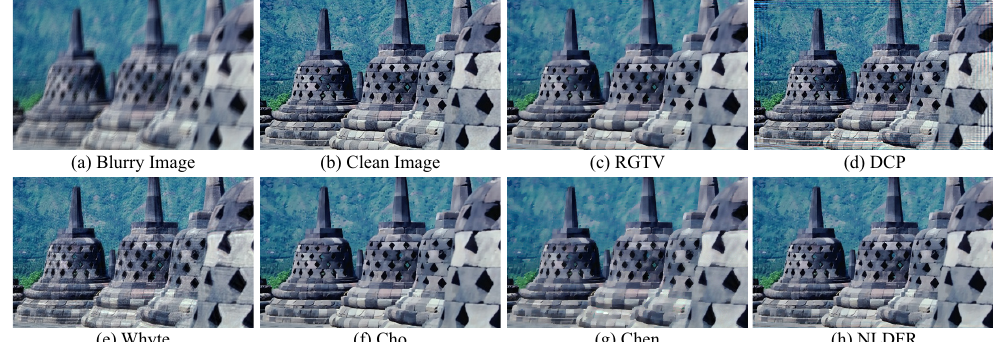
Figure 13. Results of deblurring natural image. ( a ) Clean image, ( b ) blurry image, and ( c – h ) restored by RGTV [28], DCP [5], Whyte [14], Cho [12], Chen [19], and the proposed